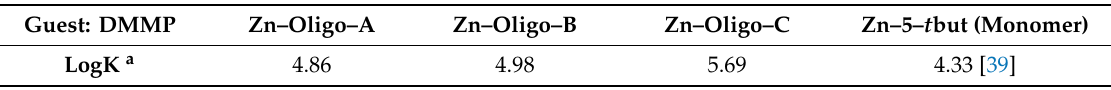
Table 2. Binding constant values of oligomeric and monomeric receptors, towards DMMP in DMSO solution.